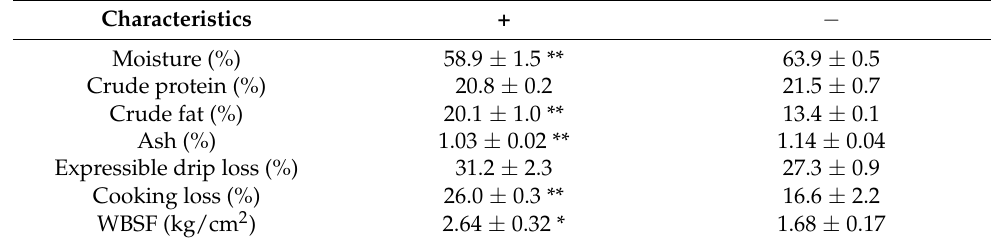
Table 1. Proximate composition, water-holding capacity, and tenderness of 26-day dry-aged beef with (+) and without ( − ) direct fungal